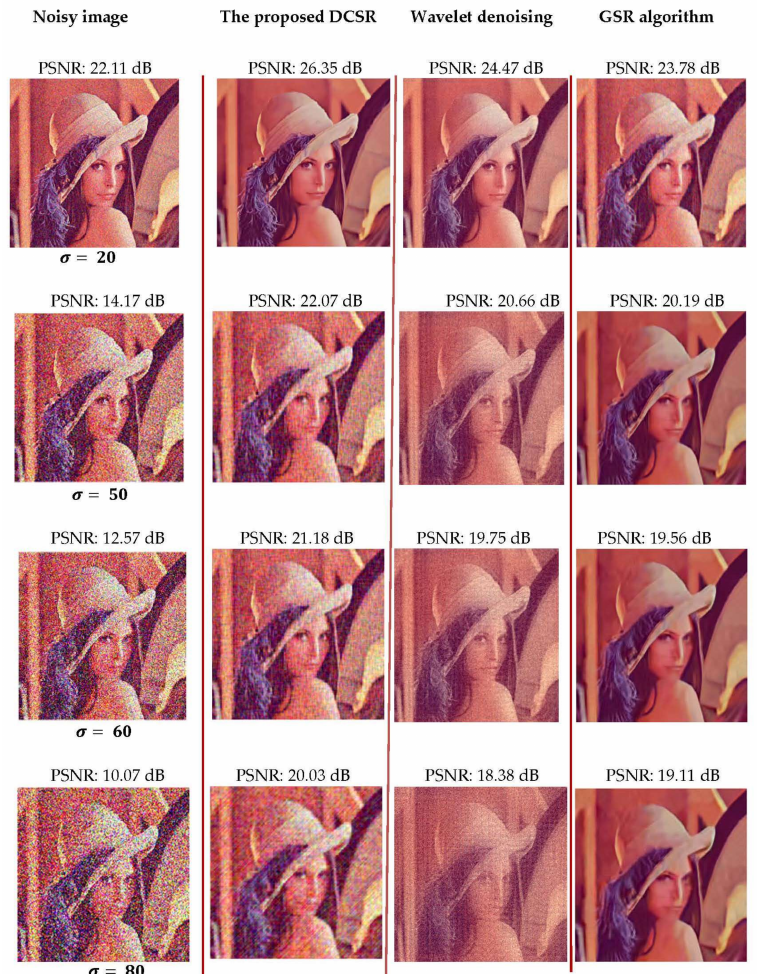
Figure 7. Restoration results of the AWGN-corrupted Lena image for different values of σ (see column 1 located on the left side of the figure). The algorithms used, the proposed DCSR, wavelet denoising and GSR, are arranged in columns 2, 3 and 4,